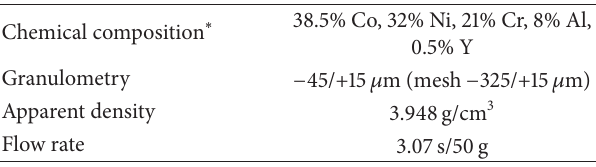
Table 1: Features of powder CoNiCrAlY.